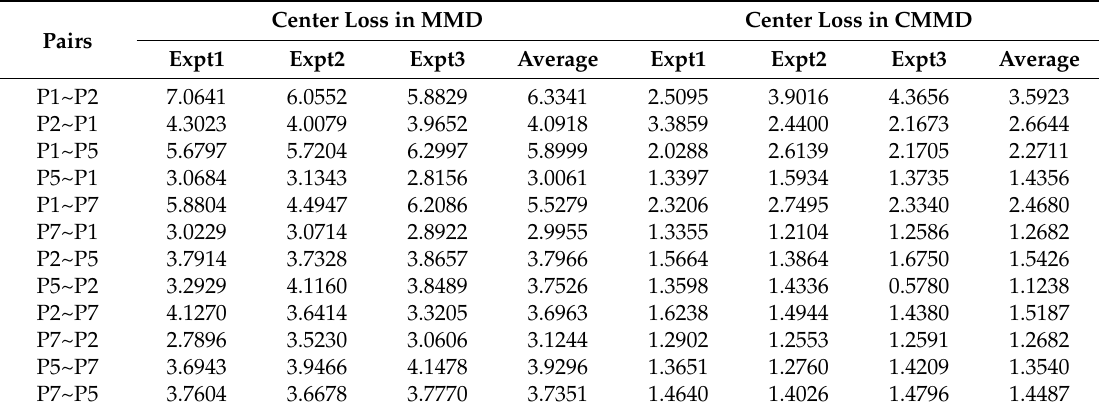
Table 12. The final Center Loss value in each